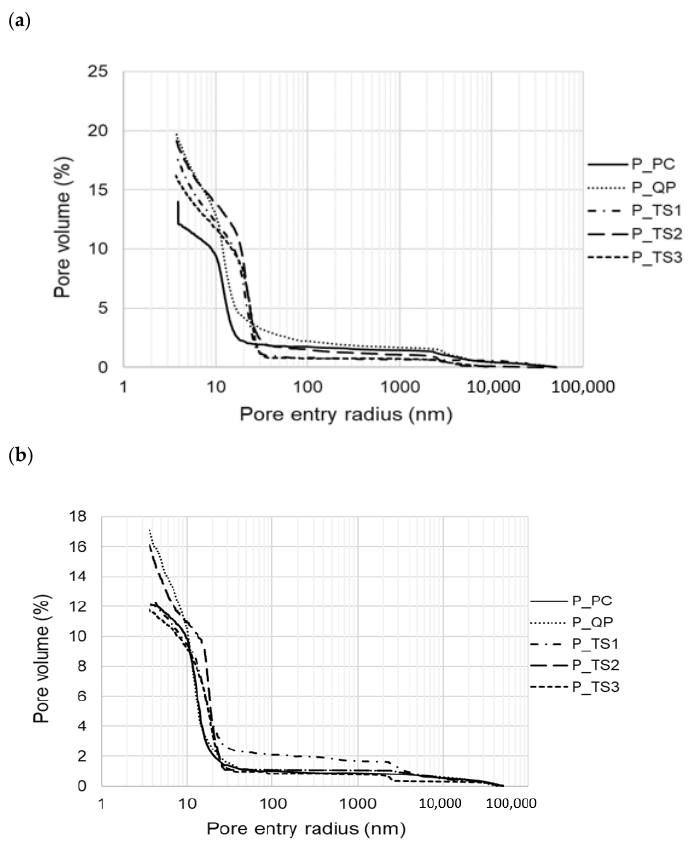
Figure 10. Pore volume of paste mixtures as a function of intruded pore diameter ( a ) at 28 days and ( b ) at 90 days.